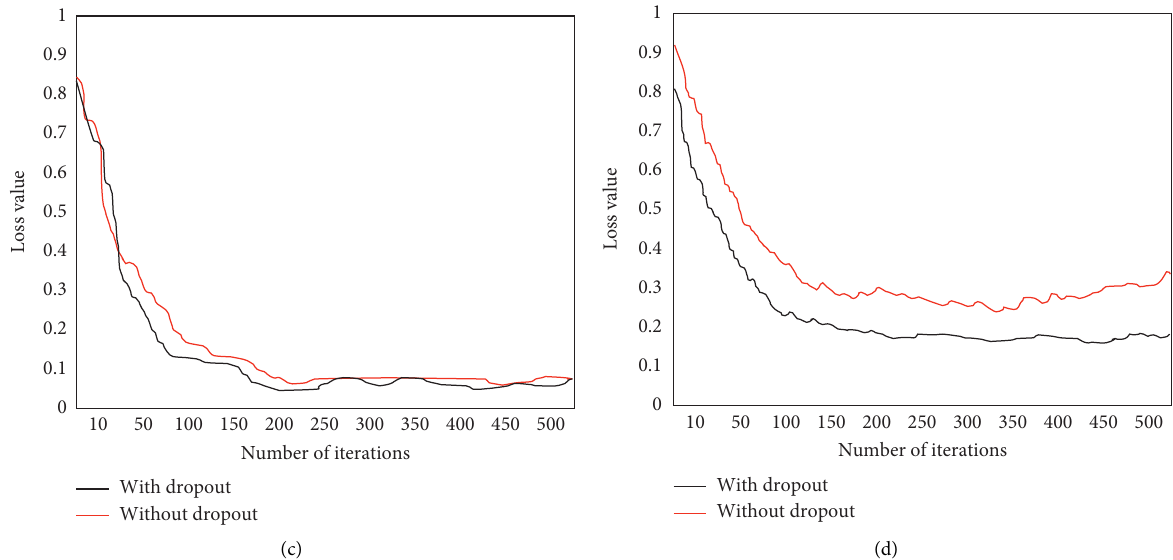
Figure 6: The change curve of the loss function of the training sample and the test sample with the number of iterations. (a) Loss value with training in HMDB51 dataset. (b) Loss value with training in UCF-101 dataset. (c) Loss value with testing in HMDB51 dataset. (d) Loss value with testing in UCF-101 dataset.